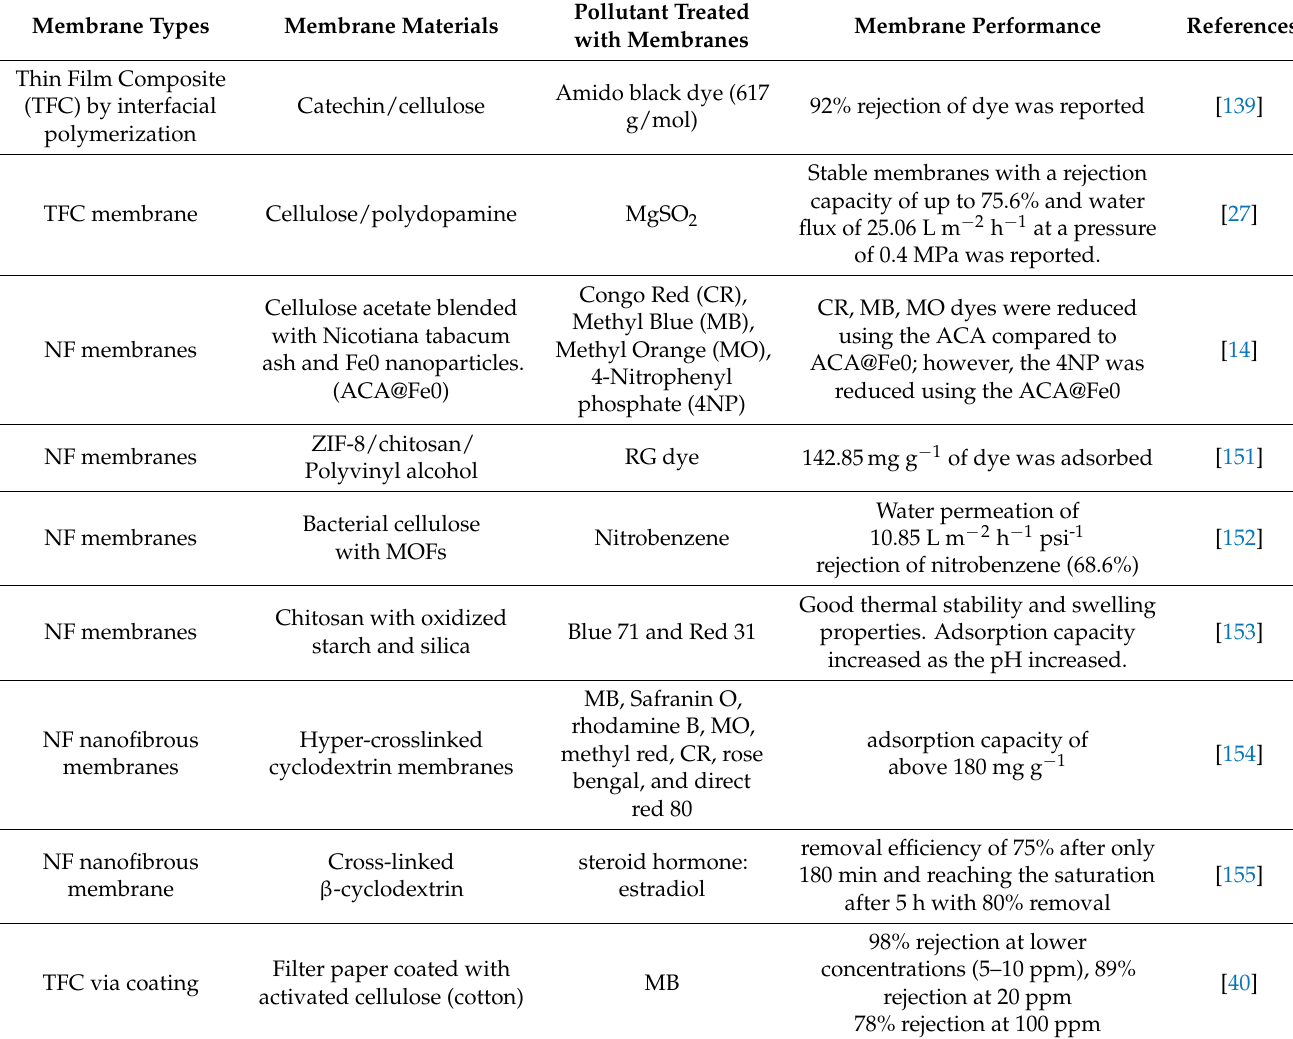
Table 2. Several effective uses of biopolymeric membranes in water